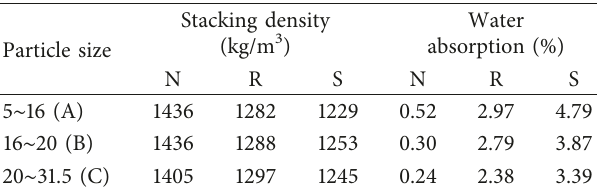
Figure 2: Appearance of coarse aggregates. Table 1: The aggregate parameters. Table 2: Mixture proportions of NAC (1m 3